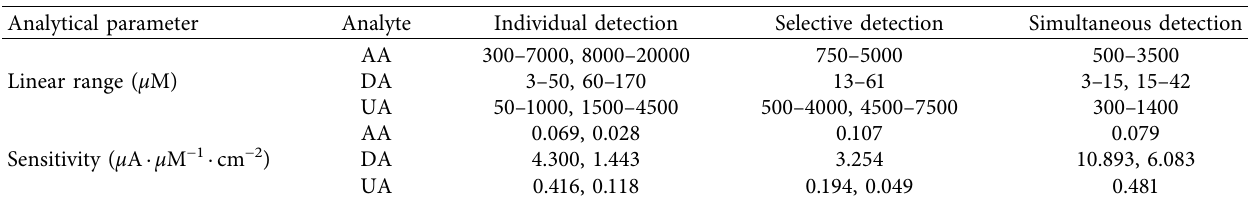
Table 1: Analytical parameters for individual, selective, and simultaneous detection of AA, DA, and UA at PdNPs/rGO/GCE. Analytical parameter Analyte Individual